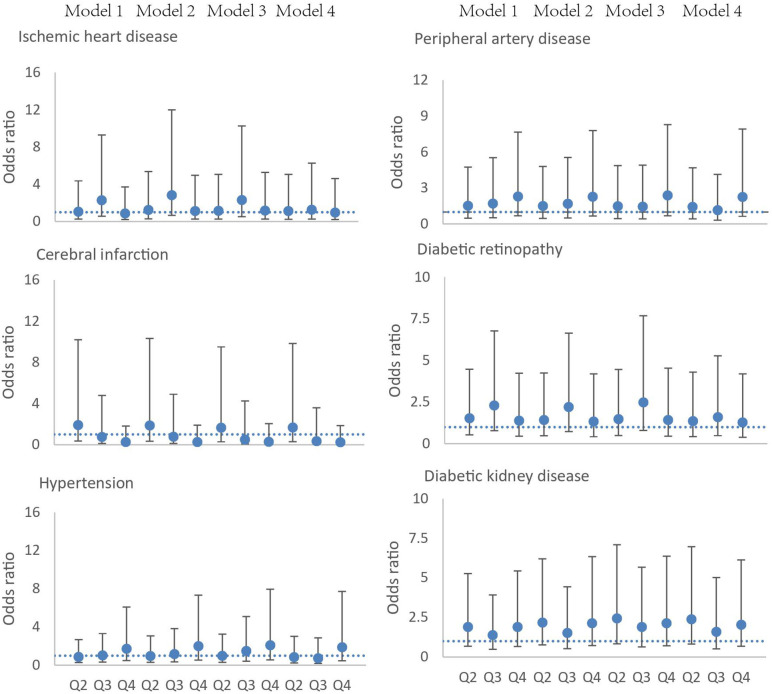
Association of the severity of OSA and ischemic heart disease, cerebral infarction, hypertension, peripheral artery disease, diabetic retinopathy, and diabetic kidney disease. Circles represent the odds ratio, and bars represent the 95% confidence interval. The severity of OSA is defined according to apnea–hypopnea index quartiles (Q1, 0–8.9 events per hour, Q2 9–17.5 events per hour, Q3 17.6–33.5 events per hour, Q4 >33.5 events per h). Model 1, adjusted for age and sex; model 2, adjusted for age, sex, smoking, and alcohol usage; model 3, adjusted for age, sex, smoking, alcohol usage, and body mass index; model 4, age, sex, smoking, alcohol usage, body mass index, and duration of diabetes.